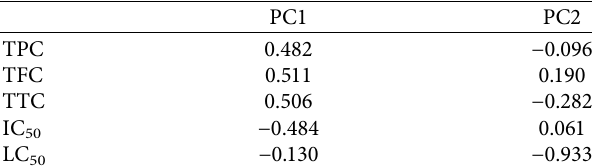
Table 11: Factor loading data of variables with PC1 and